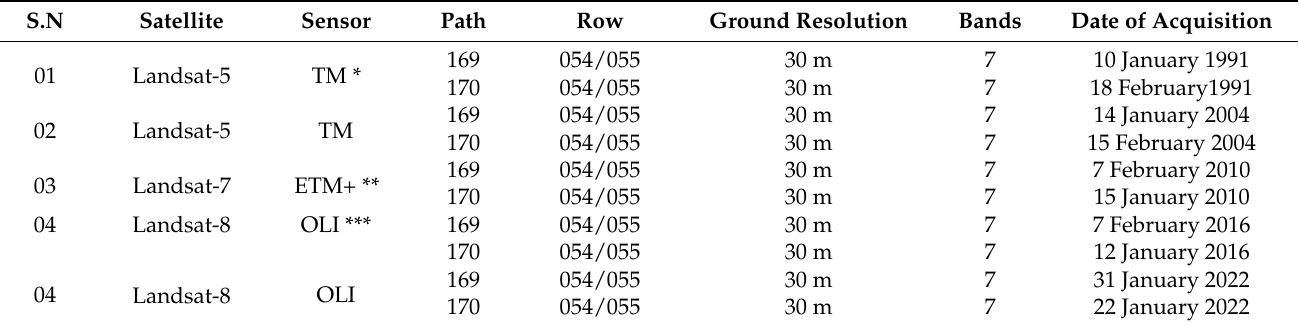
Table 1. Landsat satellite image acquisition and description .